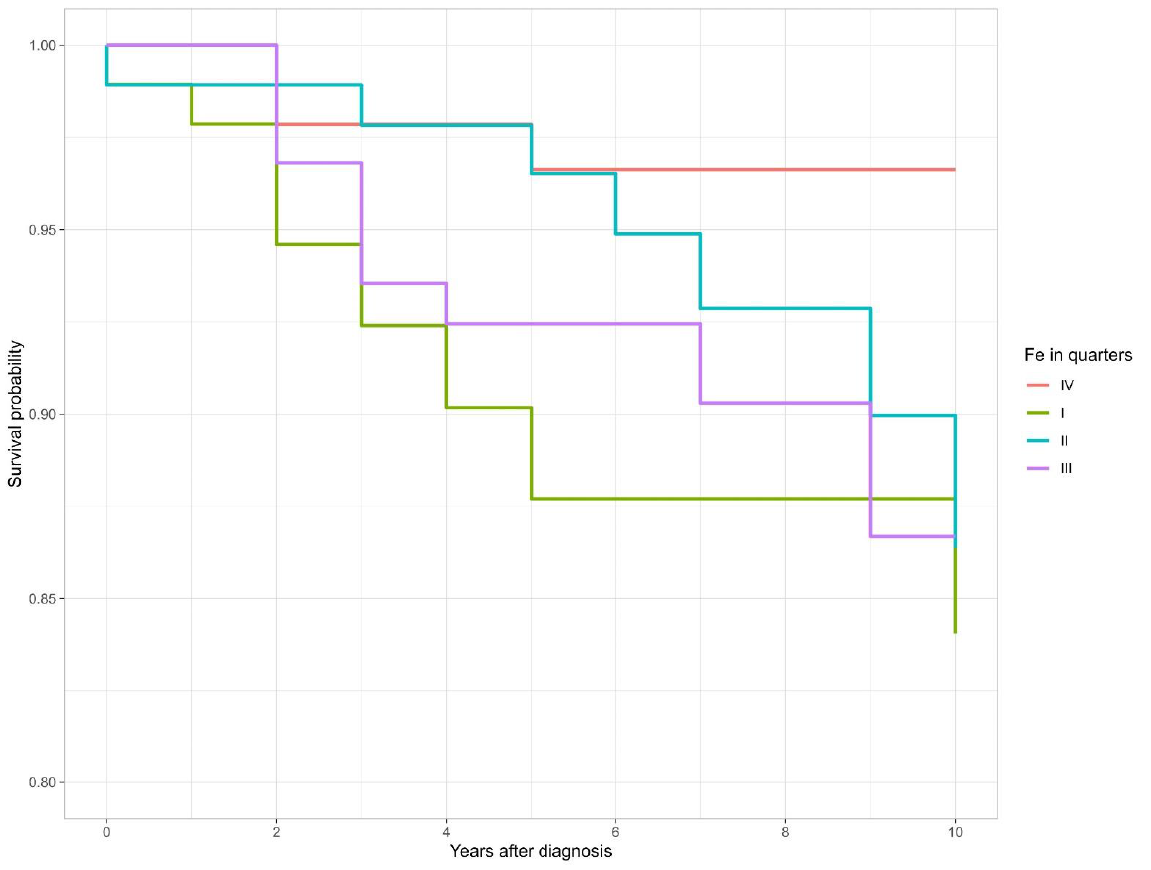
Figure 1. Ten-year survival by Fe level (quarters) in melanoma patients.